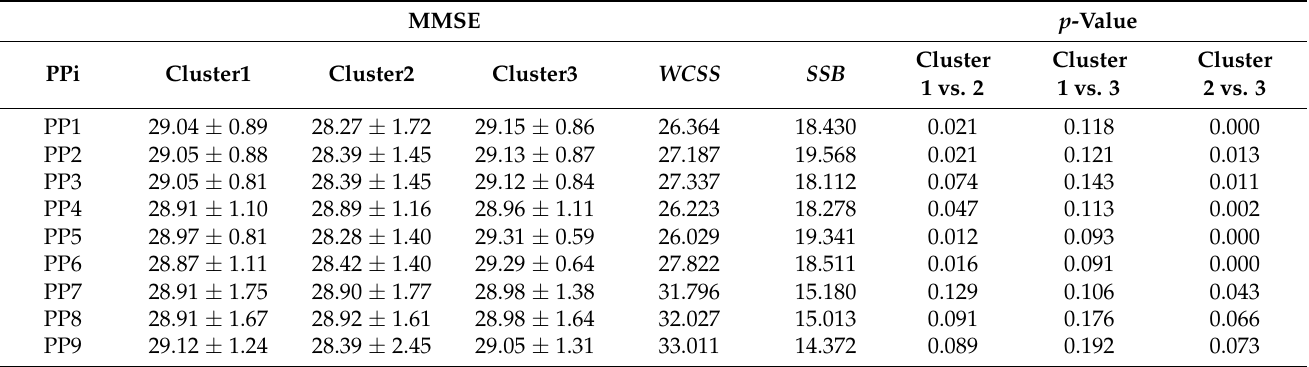
Table 2. Values of cognitive impairment obtained for each cluster in terms of the MMSE. MMSE p -Value Cluster2 Cluster3 WCSS SSB